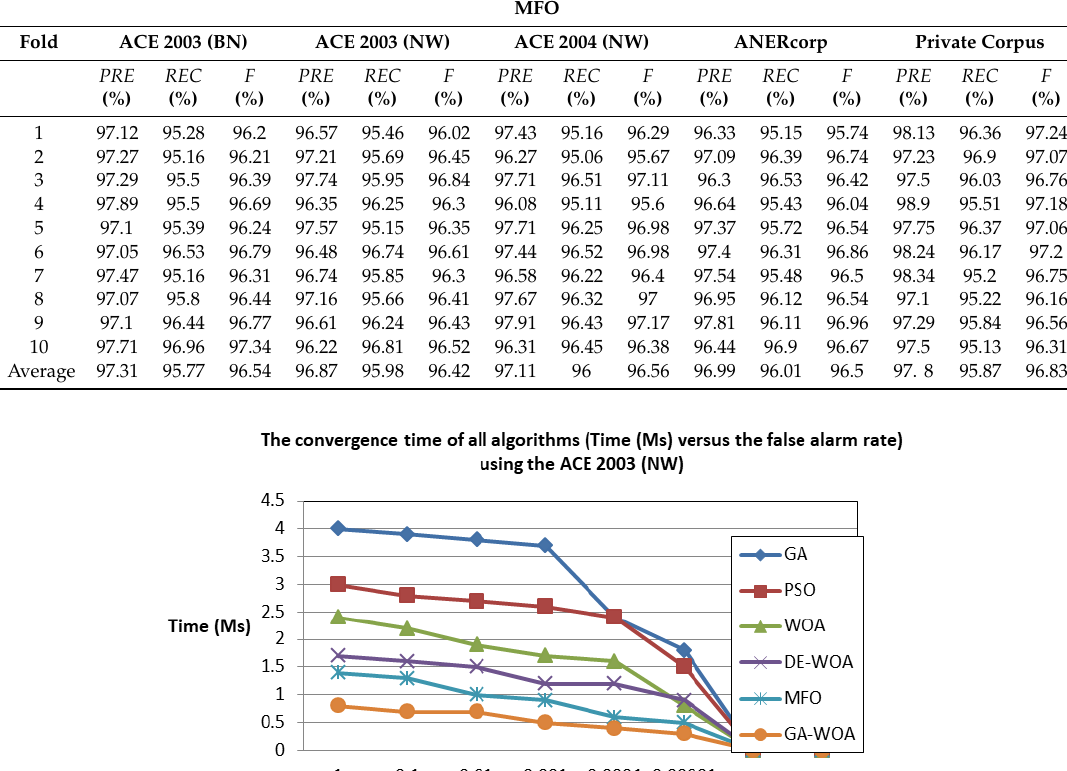
Table A6. Performance evaluation of ontology learning using the DE-WOA over the five corpora. MFO Fold